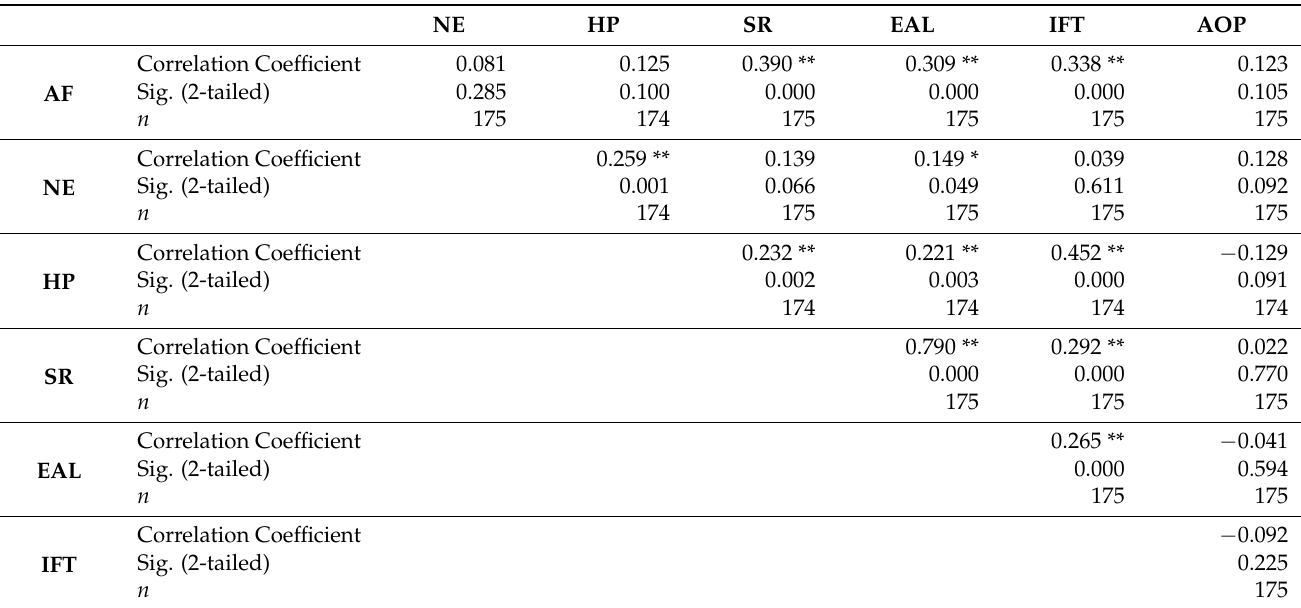
Table 2. Correlations, Spearman Rho: